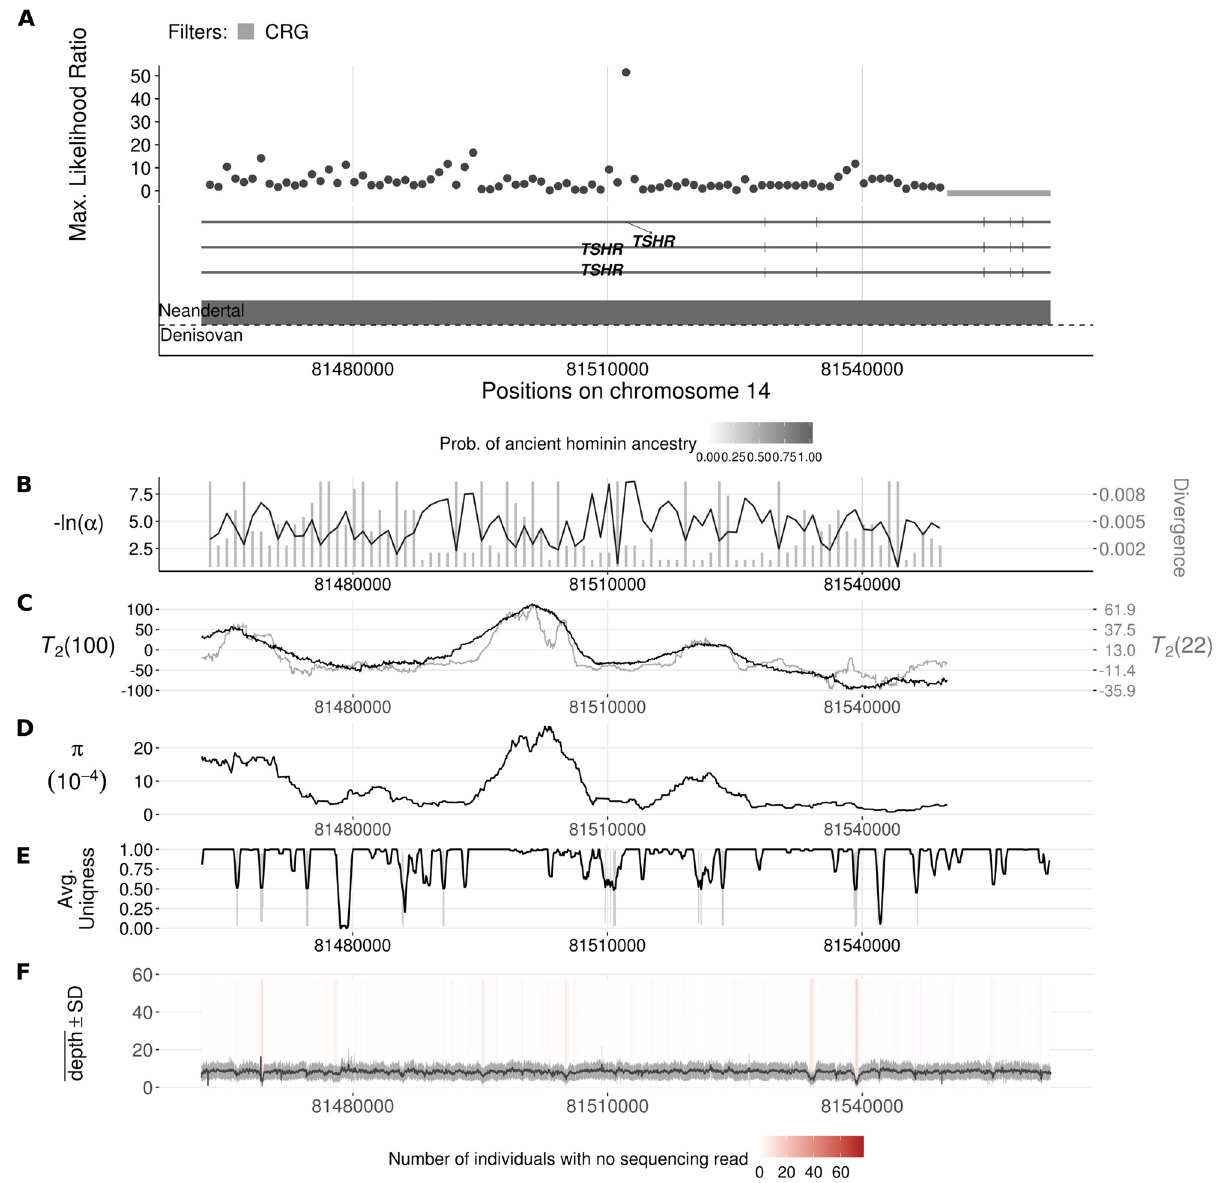
Fig 7. Introgression sweep signals, tracks of Neanderthal or Denisovan ancestry, parameter estimates, and sequencing properties across the 100 kb region on chromosome 14 covering the TSHR gene in CEU. A . Likelihood ratio test statistic computed from Model 1 of VolcanoFinder on data on within-CEU polymorphism and substitutions with respect to chimpanzee. Horizontal light gray bars correspond to regions that were filtered based on mean CRG. Gene tracts and labels for key genes are depicted below the plot, with the wider bars representing exons. Tracks of putative regions with Neanderthal (above the horizontal line) or Denisovan (below the horizontal line) ancestry are located below gene diagrams. Higher probabilities of Neanderthal or Denisovan ancestry are depicted with darker colored bands (data from [22]). Non-synonymous mutations with Neanderthal are indicated in red. B . Values for α and divergence D corresponding to the maximum likelihood estimate of the data. Black line corresponds to − ln( α ) and vertical gray bars correspond to estimated D . C . Likelihood ratio test statistic computed from T 2 of BALLET on data on within-CEU polymorphism and substitutions with respect to chimpanzee using windows of 100 (black) or 22 (gray) informative sites on either side of the test site. D . Mean pairwise sequence difference ( ^ y ) computed in five kb windows centered on each polymorphic site. E . Mappability uniqueness scores for 35 nucleotide p sequences across the region. F . Mean sequencing depth across the 99 CEU individuals as a function of genomic position, with the gray ribbon indicating standard deviation. The background heatmap displays the number of individuals devoid of sequencing reads as a function of genomic position, with darker shades of red indicating a greater number of individuals with no sequencing